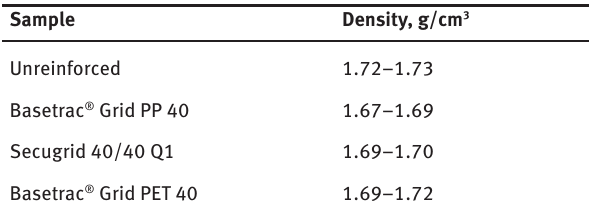
Table 2: Density of investigated samples.